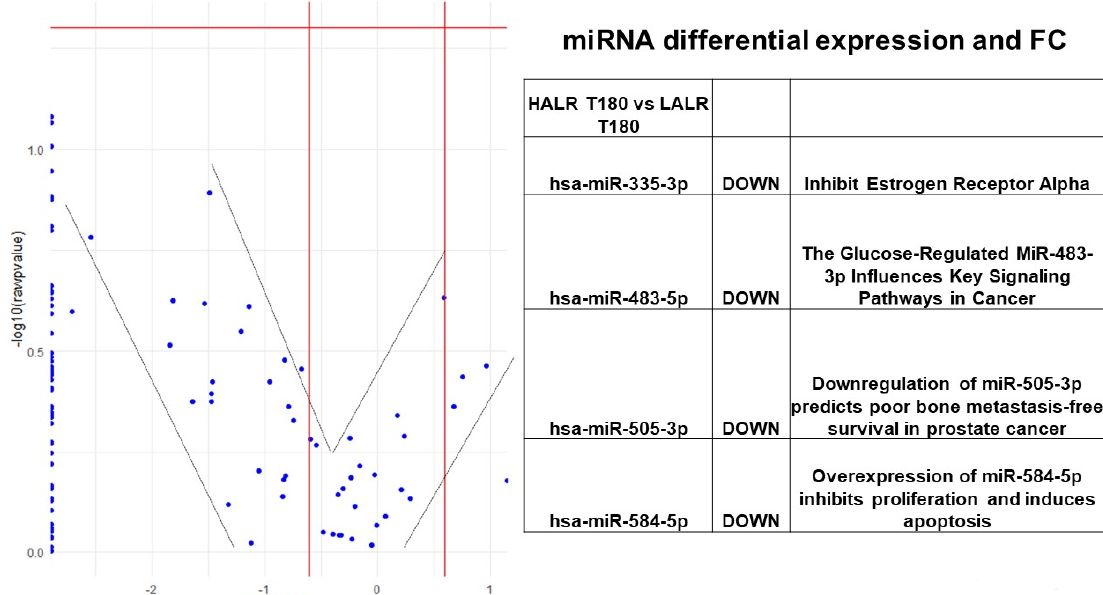
Figure 4. Heat maps with differences in miRNA signatures for Time 180 ′ (peak of postprandial response) after a mixed meal among participants with (H) vs. (L)ALR.